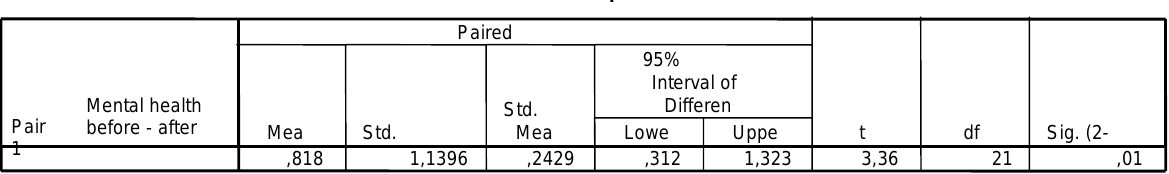
Mental Health Significantly Improved with Clinical Holistic Medicine, Even When Former Psychiatric/Psychological Treatment